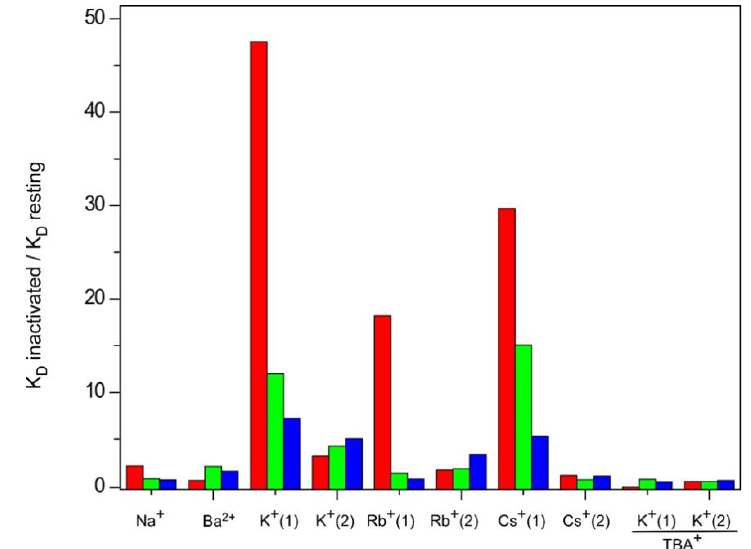
Figure 10. Relative affinities for nonpermeant and permeant cations presented by the three KcsA inactivated model channels, with respect to the resting state. The bar graph shows the ratio between the mean apparent K D ’s of the inactivated and resting states given in Table 1. Colors represent: KcsA at pH 4 ( ■) , 1–125 KcsA at pH 7 ( ■) and OPEN KcsA at pH 7 ( ■) .